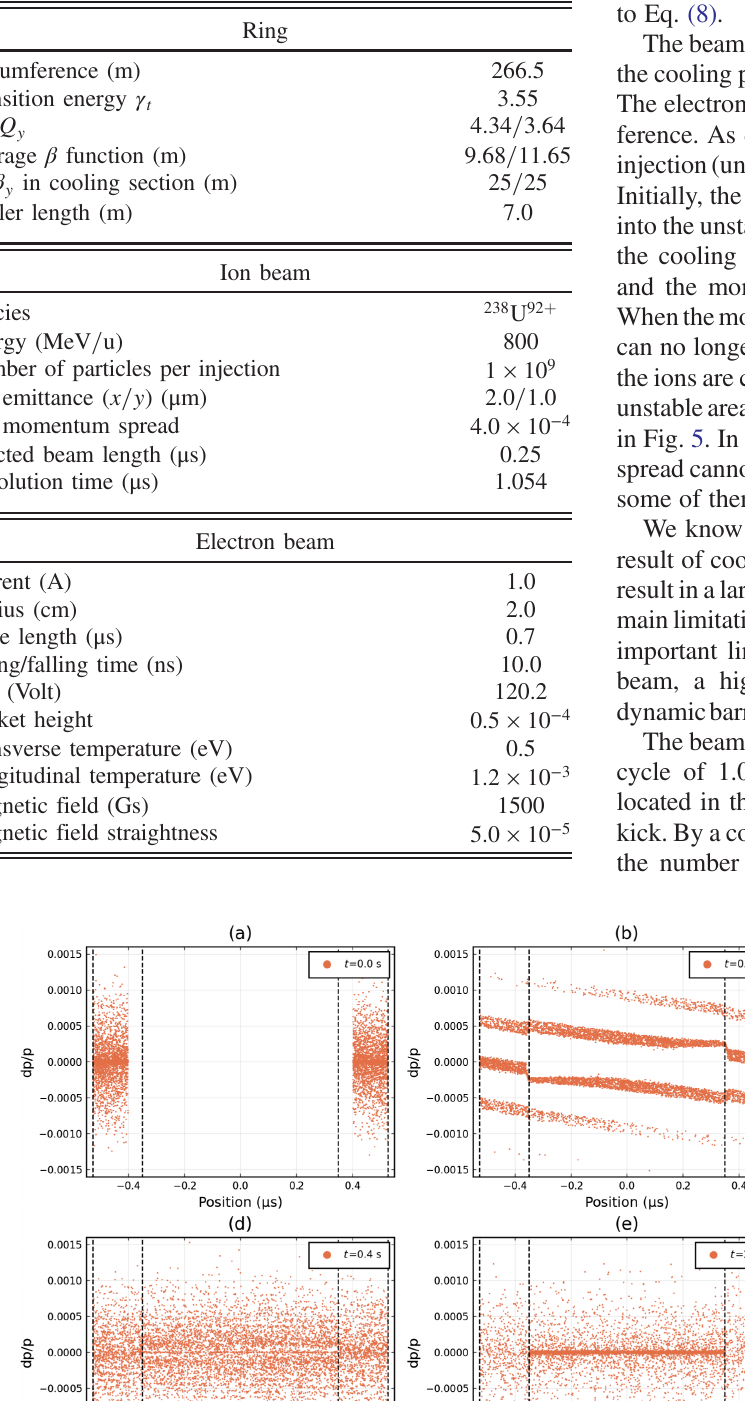
TABLE I. Beam parameters in the simulation.